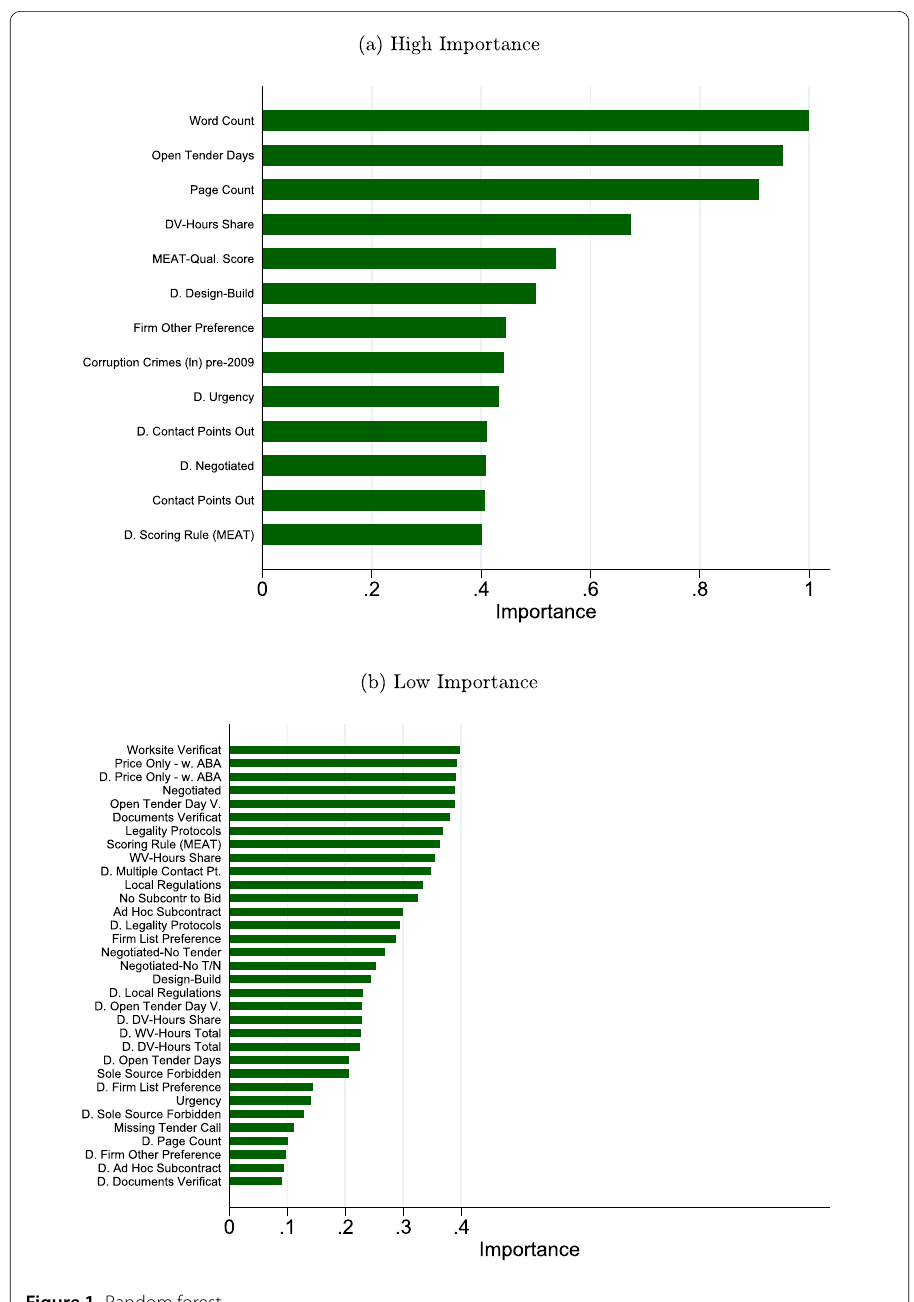
Figure 1 Random forest